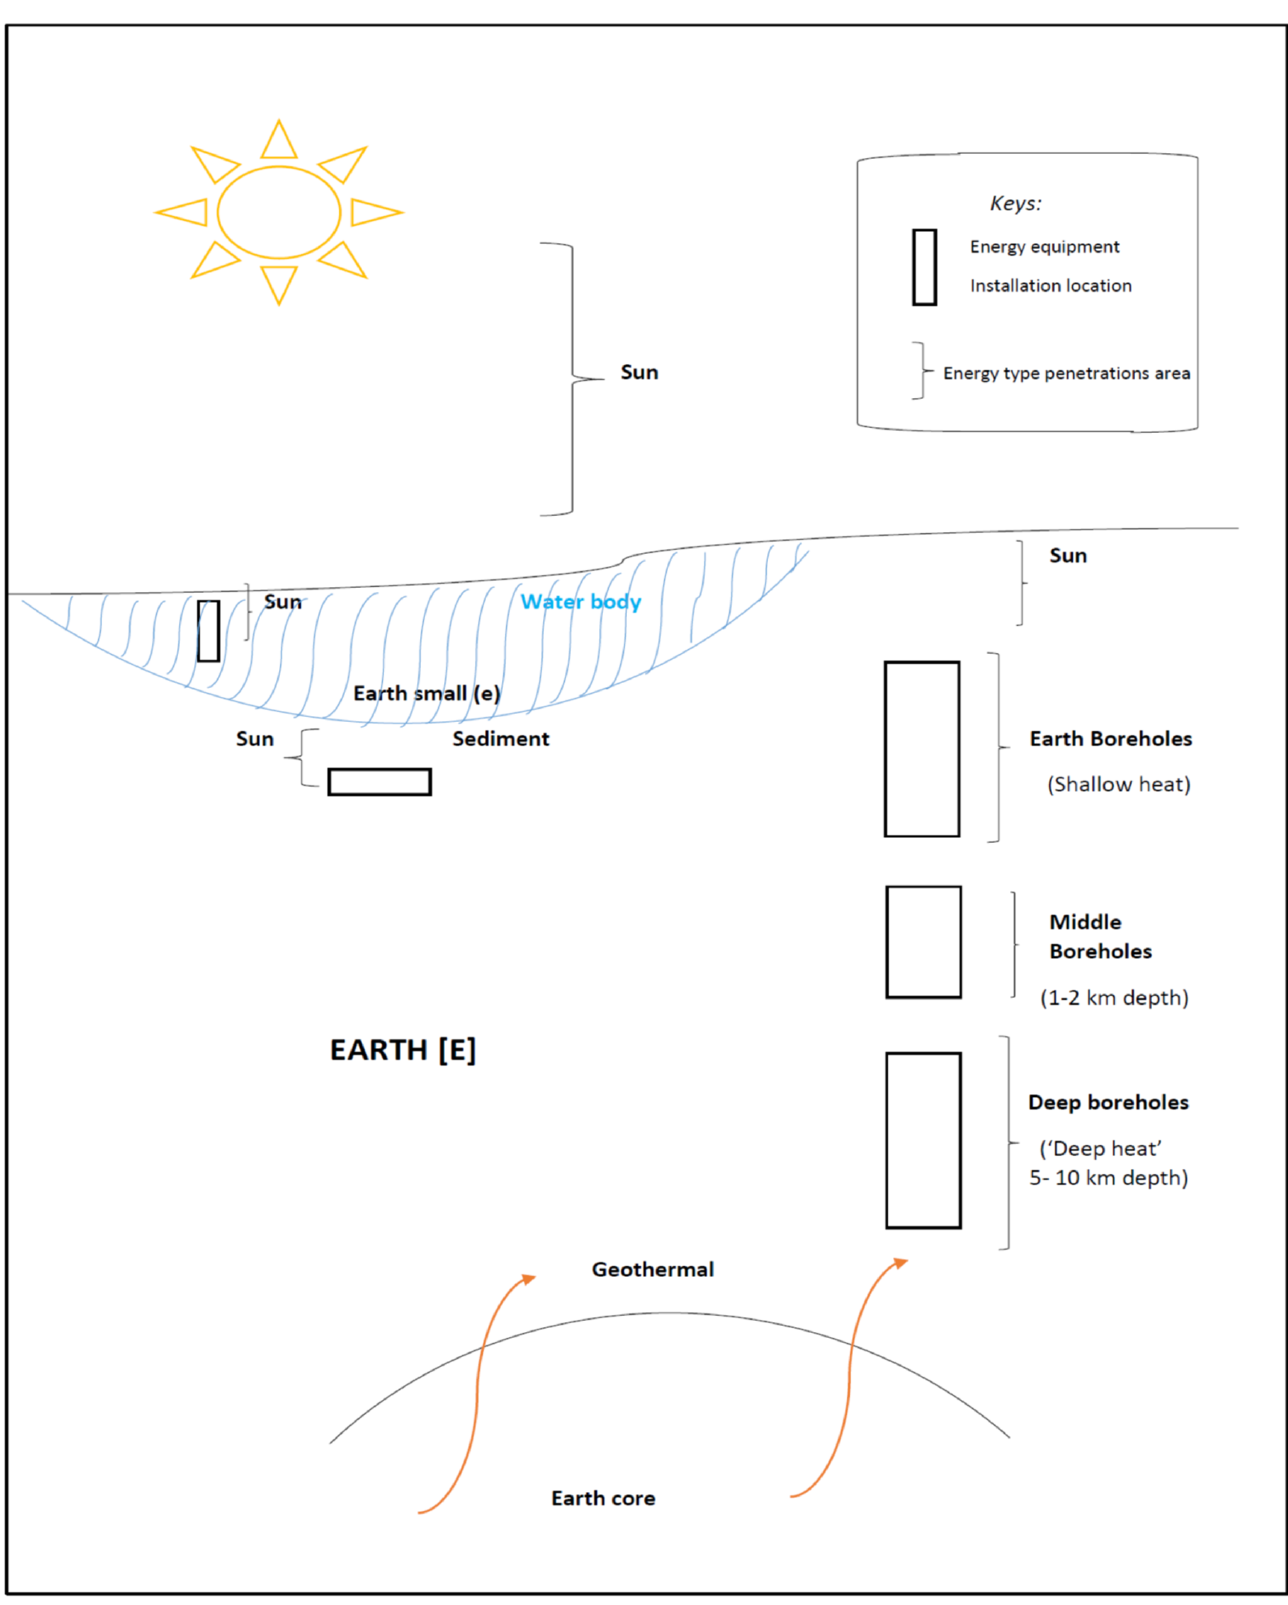
Figure 1. Sketch figure showing possible geothermal-energy solution for installation near seaside or water body areas (e.g., near a lake or sea).